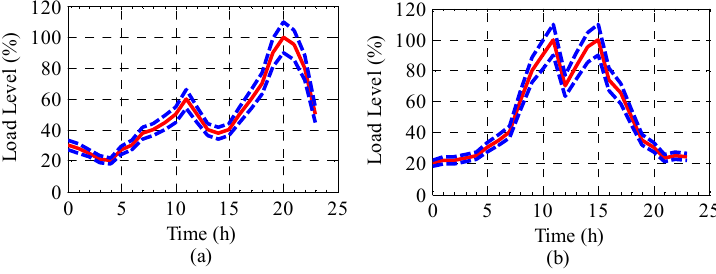
Figure 5. Prediction intervals of loads in 24 h (the dotted lines denote the upper and lower bounds, and the real lines denote predicted value). ( a ) Loads on Feeder 1; ( b ) loads on Feeders 2 and